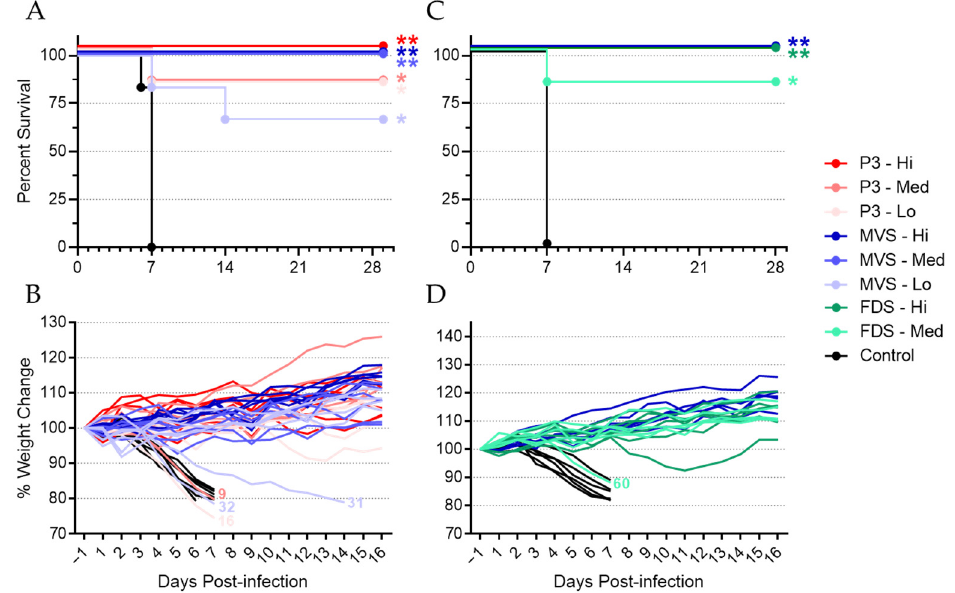
Figure 2. PHV01 prevents death and disease following MARV challenge. In Experiment #1 ( A , B ), guinea pigs (n = 6) were vaccinated with rVSV ∆ G-MARV P3 and PHV01 MVS at one of three different dose levels (high, medium, or low). In Experiment #2 ( C , D ), guinea pigs (n = 6) were vaccinated with PHV01 FDS at one of two different dose levels (high or medium) or with PHV01 MVS at the high dose level. Control animals (n = 6) in both experiments received saline. Twenty-eight days after vaccination, animals were challenged with a lethal dose of guinea-pig-adapted MARV and monitored for survival ( A , C ) and weight change ( B , D ). Survival curves for all vaccinated groups were significantly different from the control groups (Log-Rank with Bonferroni correction; *, p ≤ 0.05; **, p ≤ 0.01). Vaccinated animals that did not survive infection are indicated on the weight loss curves by their respective animal numbers: 9, rVSV ∆ G-MARV P3 medium dose; 16, P3 low dose; 31 and 32, PHV01 MVS low dose; 60, PHV01 FDS medium